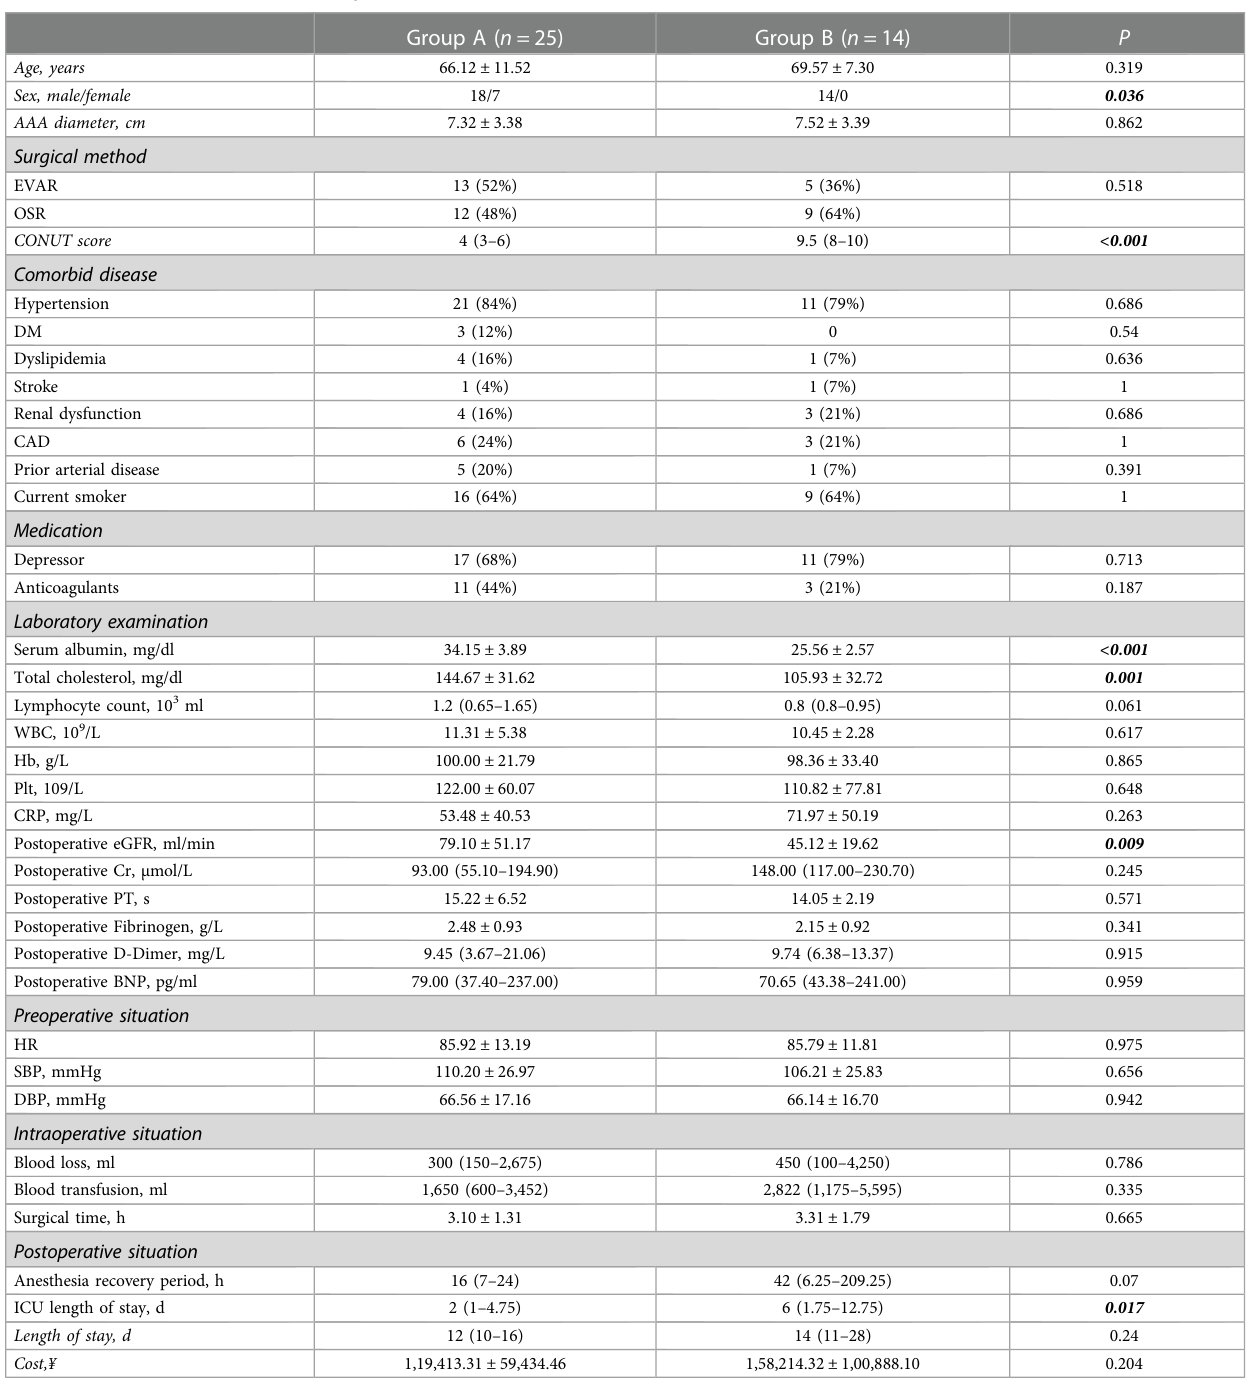
TABLE 2 Basic characteristics of included